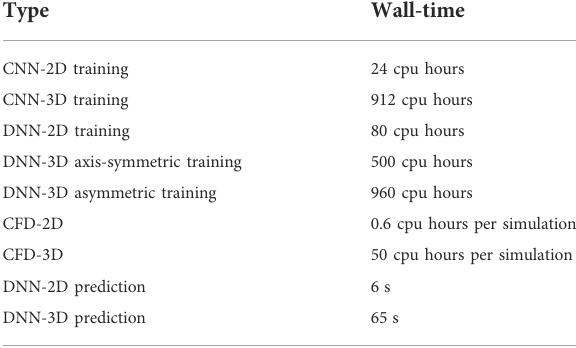
TABLE 3 Details of the computation